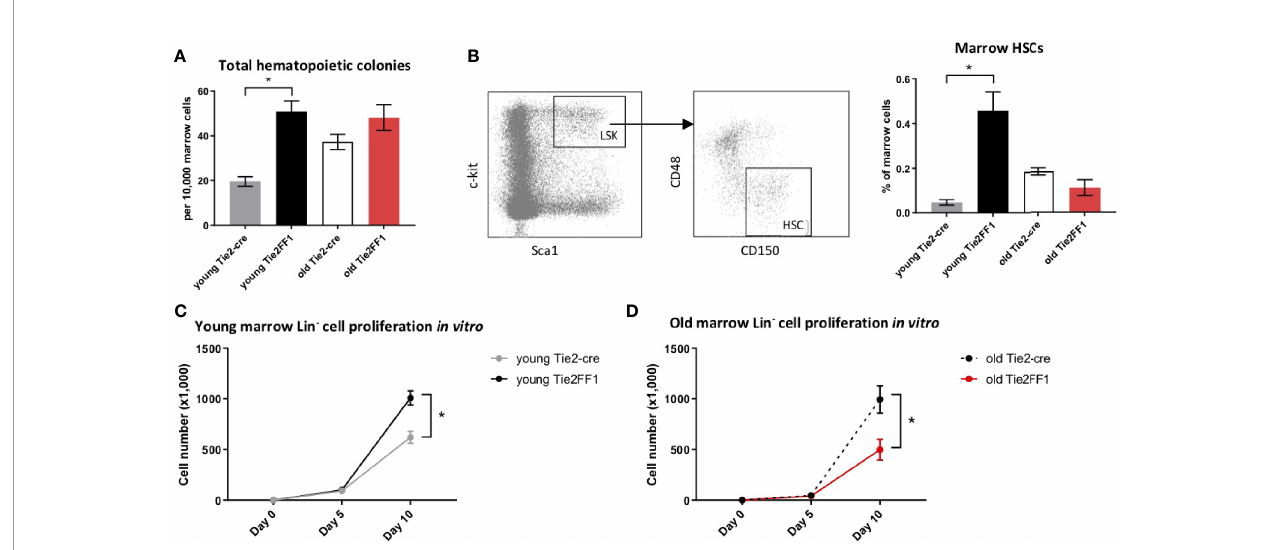
FIGURE 2 | Decreased marrow hematopoiesis in the Tie2FF1 mice during aging. (A) Colony formation assays in marrow cells isolated from young (n=4 mice in each group) and old (n=6-7 mice in each group) Tie2-cre control and Tie2FF1 mice. (B) Representative fl ow cytometry plots showing gating strategy (left) of marrow Lin cKit + Sca1 + CD150 + CD48 - HSCs frequency (right) in young (n=7 mice in each group) and old (n=5-6 mice in each group) Tie2-cre control and Tie2FF1 mice. (C, D) Cell proliferation of marrow Lin- HSPCs isolated from young (C) and old (D) Tie2-cre control and Tie2FF1 mice. Cells were cultured on SFEM medium containing recombinant mouse SCF (1OOng/mL), recombinant mouse IL3 (6ng/mL), and recombinant human IL6 (1Ong/mL). Data are from one of two independent experiments (with triplicates in each experiment) that gave similar results. * P < 0.05